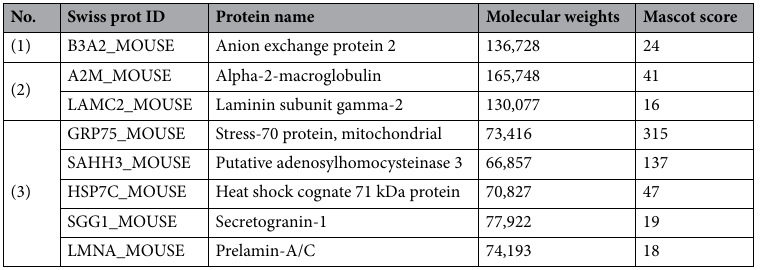
Table 1. IRBIT family binding protein in B16F10 mouse melanoma cell line. Each number indicates an arrow or arrowhead in Fig. 1A (1): closed arrowhead (2): open arrowhead (3): closed